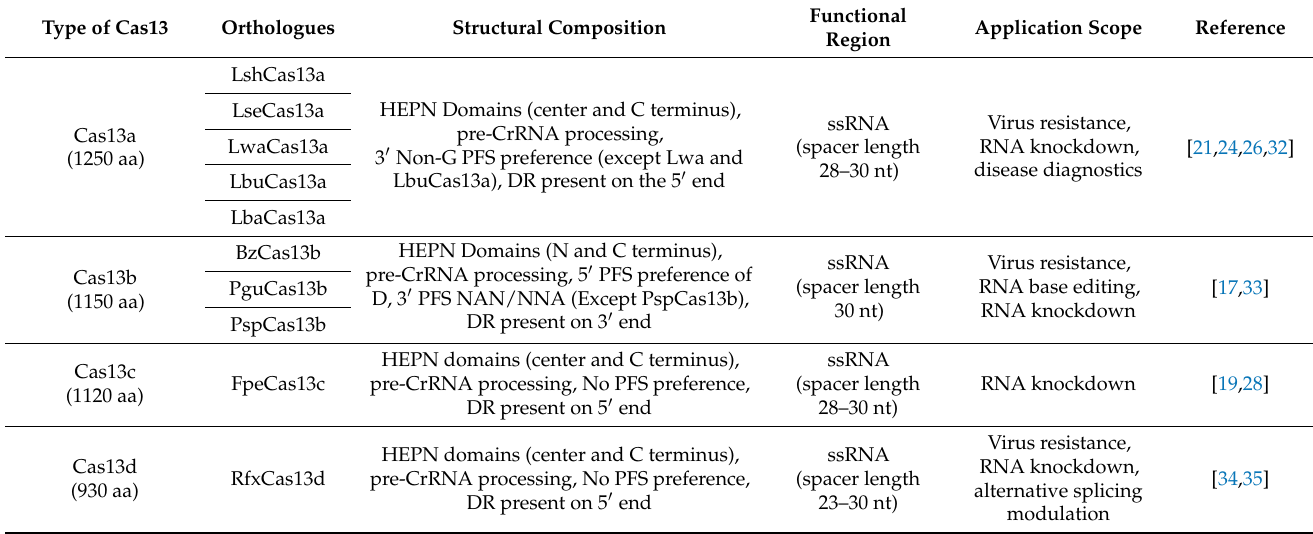
Table 1. Summary table of CRISPR/Cas13